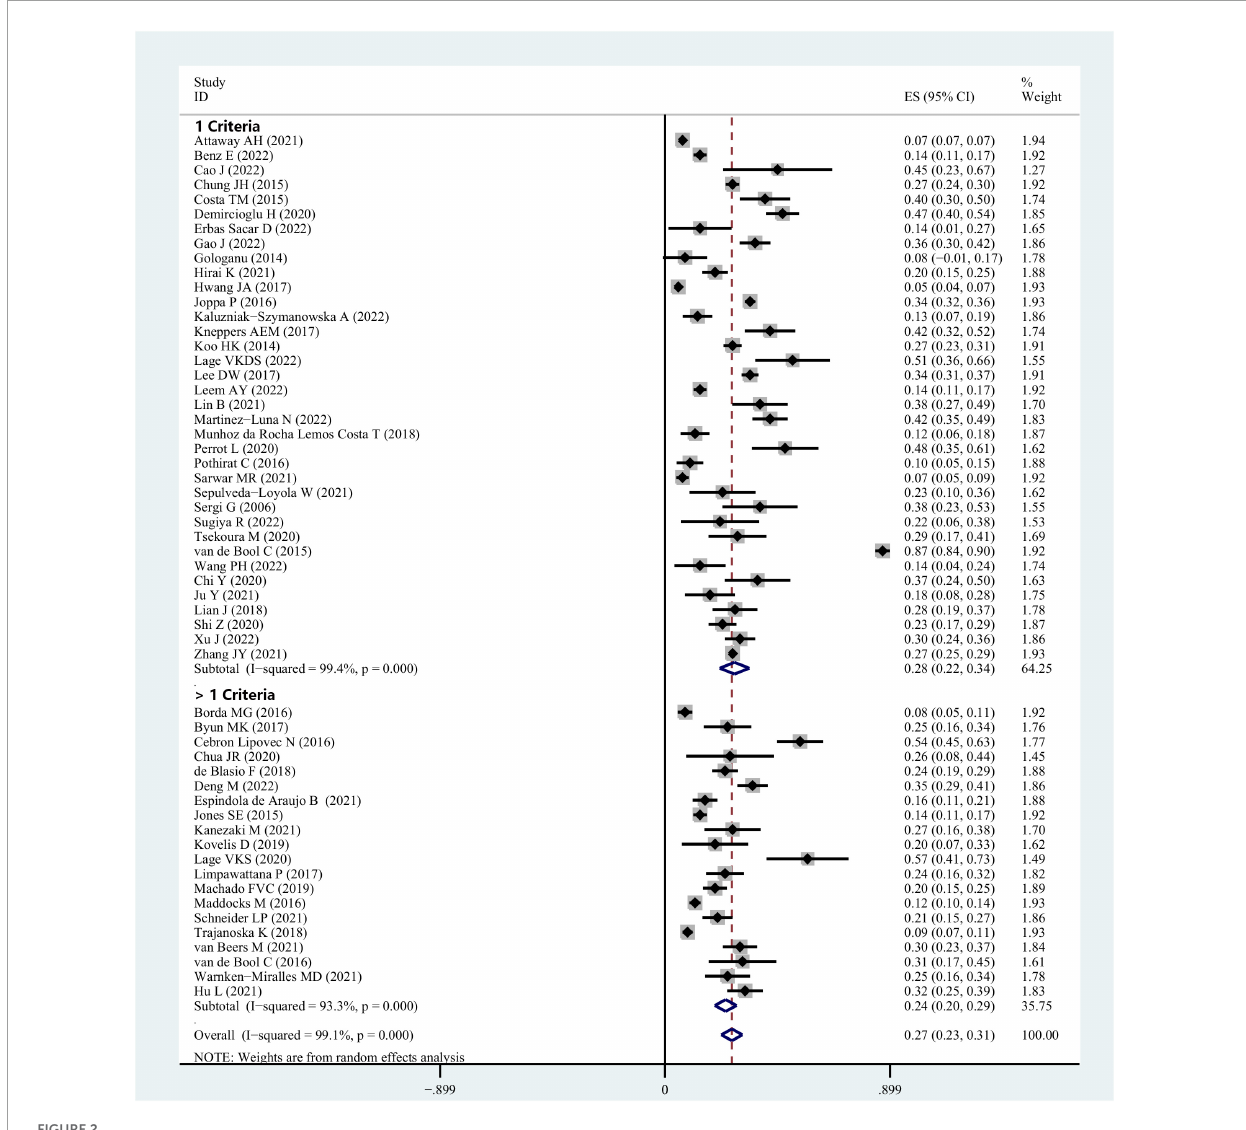
FIGURE2 Prevalence of sarcopenia in COPD patients based on a random efforts